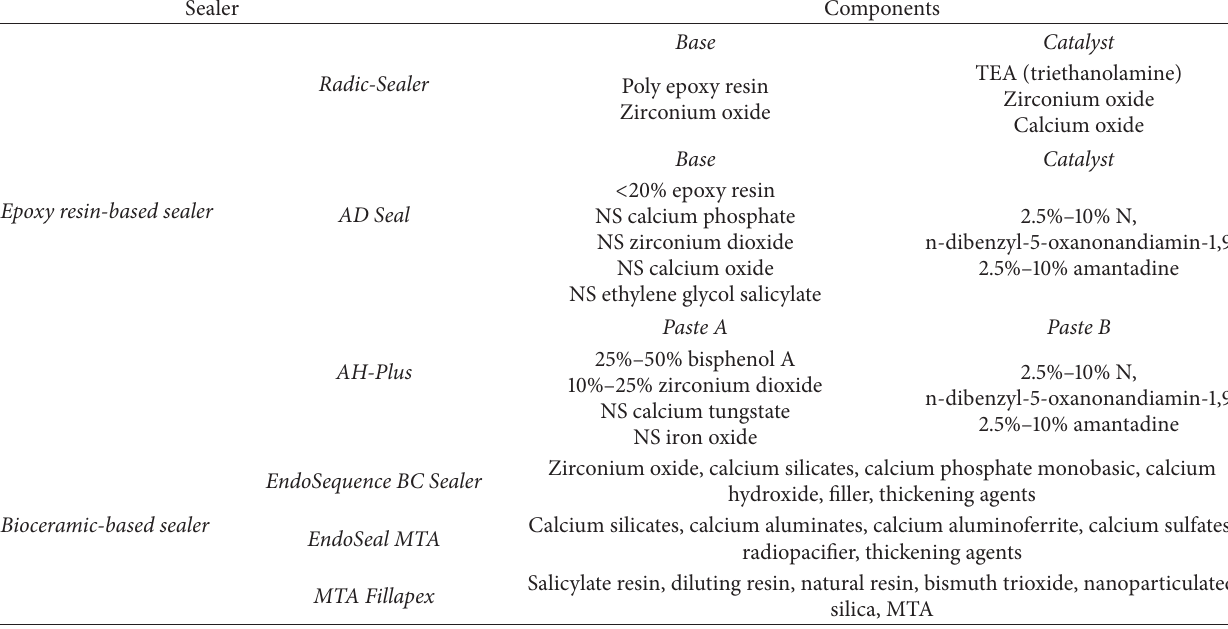
Table 2: Chemical compositions of the root canal sealers investigated in the present